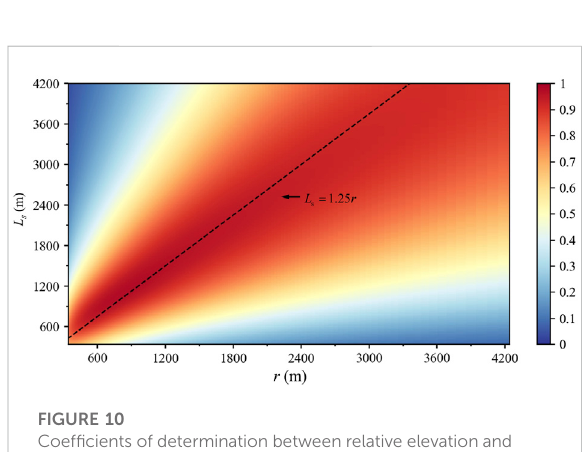
FIGURE 10 Coef fi cients of determination between relative elevation and smoothed curvature with various r and L s